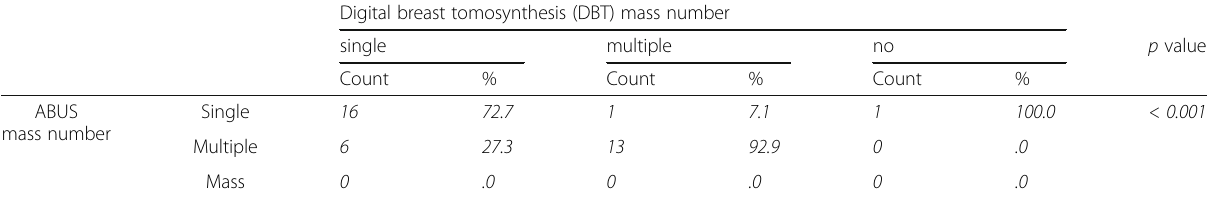
Table 4 Relation between both modalities regarding the number of masses Digital breast tomosynthesis (DBT) mass number